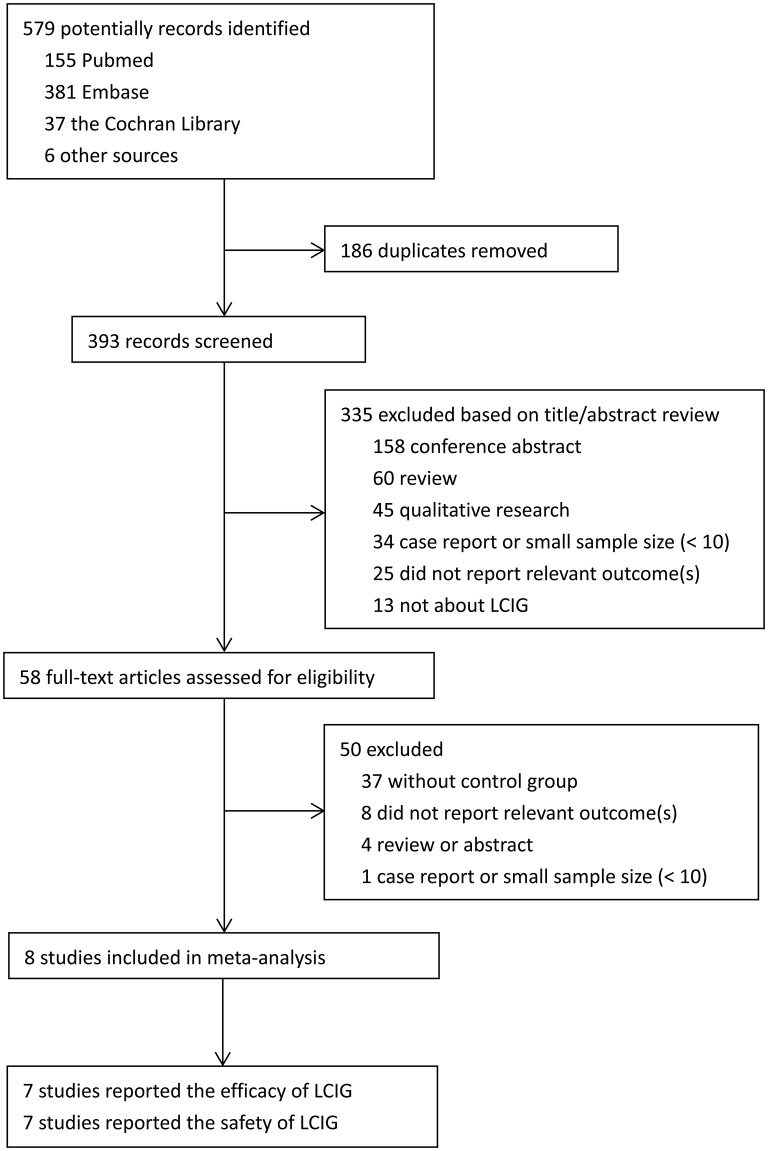
PRISMA flow chart of Study Selection in Meta-analysis.